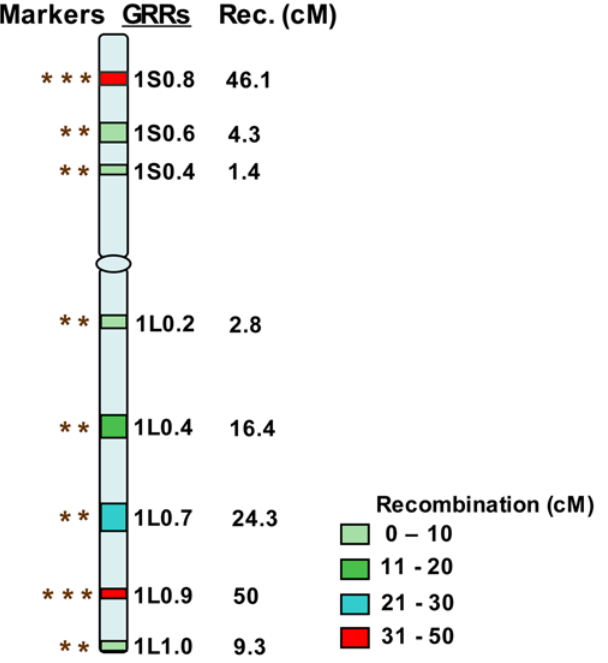
Figure 5. Strategy for selection of markers for marker-assisted backcross breeding program. Example is given for consensus chromosome of group 1. Names of the GRRs are provided on the right side of a consensus chromosome. In the nomenclature of GRRs (e.g. ‘1S0.8’), the first digit represents wheat homoeologous group followed by the arm location either as short arm (S) or long arm (L). The last two numeral numbers represent GRR location as fraction length (FL) of the chromosome (e.g. 0.8 for ‘1S0.8’). Along with GRRs the recombination in cM observed for particular GRRs is also given. On the left side of the consensus chromosome, * denotes the number of markers selected for a particular GRR region. Number of markers selected for each GRR was variable. For example the regions showing high recombination, like GRR 1L0.9, three markers were selected, two flanking and one from the middle of the GRR, whereas in the case of a GRR like 1S0.4, only two markers flanking the GRR was selected. (Table 3), although the non-carrier chromosome estimates are the same as that for a single gene transfer. If a transfer involves more than two unlinked genes, each set of two genes should be transferred independently. At the end of the BC 2 cycle, the selected plant from each lineage should then be crossed to each other and the F 1 should be subjected to DH production in order to select plants carrying all desired genes.